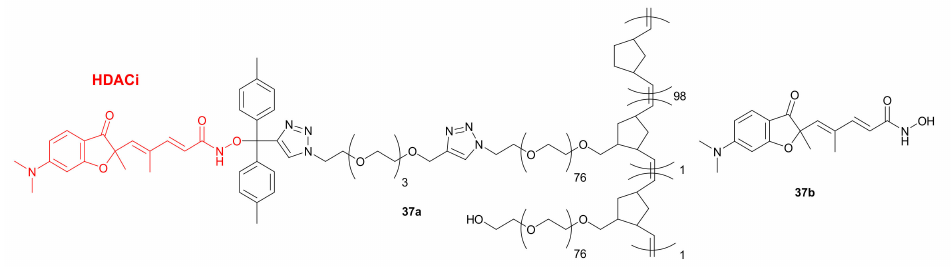
Figure 18. Chemical structures of compounds 37a and 37b